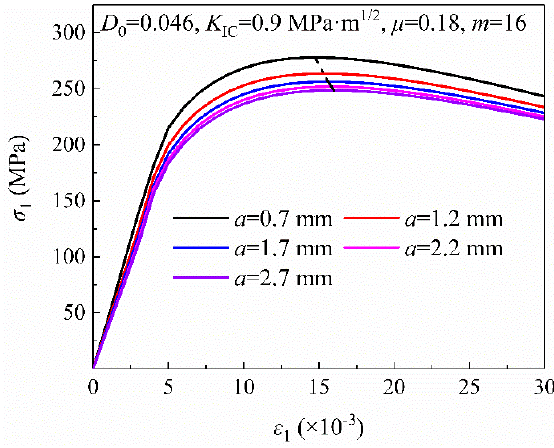
Figure 11. Effects of initial crack size on stress-strain relationship.